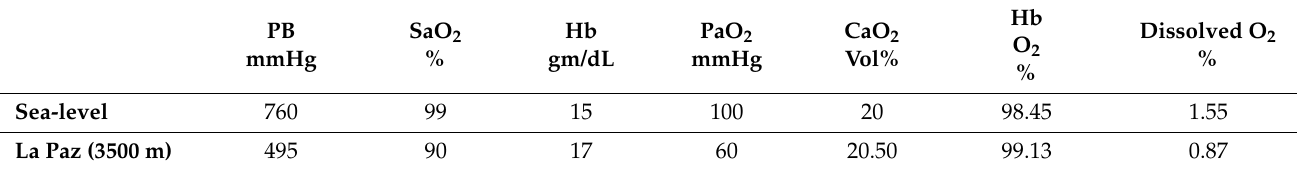
Table 1. Calculated arterial oxygen content (CaO 2 ) differences between sea level and high altitude. PB = barometric pressure, SaO 2 = arterial hemoglobin oxygen saturation, Hb = hemoglobin, PaO 2 = arterial oxygen partial pressure, Hb O 2 % is the fraction of oxygen transported by hemoglobin, and dissolved O 2 is the fraction of O 2 dissolved in